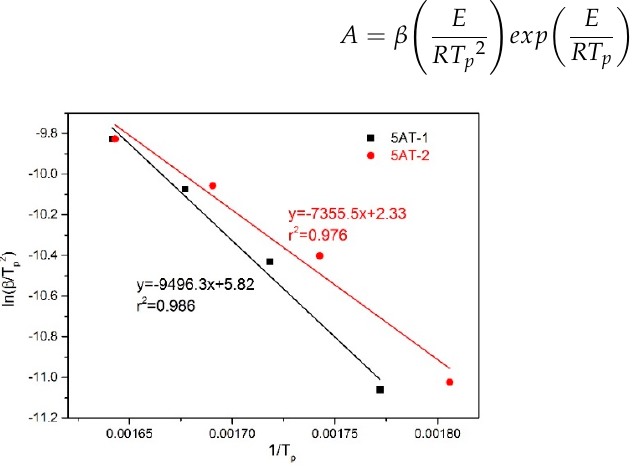
Figure 10. The numerical relationship between ln( β / T p2 ) and 1/ T p for 5AT–1 and 5AT–2.